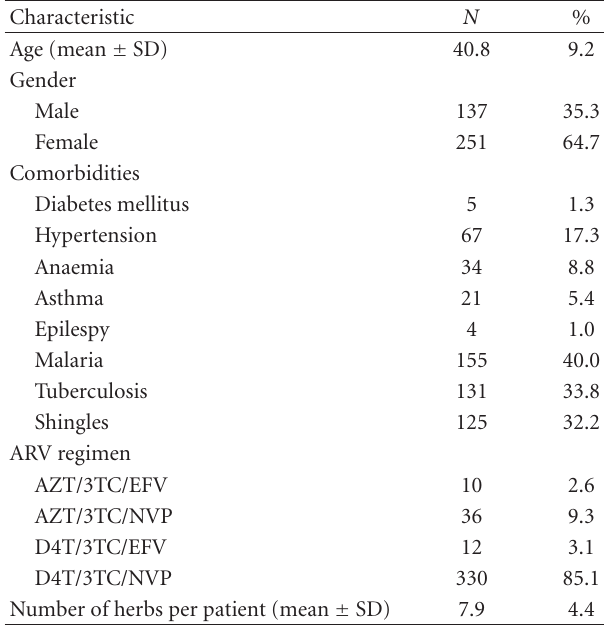
Table 1: Demographic and clinical characteristics of study patients. Unless specified, figures represent frequencies and